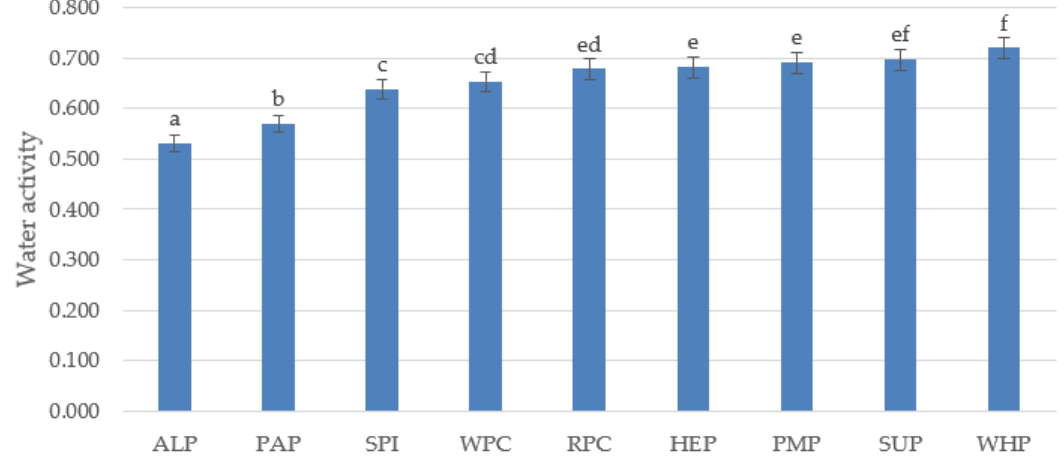
Figure 1. ( a – i ) Microstructure of high-protein bars from the scanning electron microscope (SEM HV: 30 kV, View field: 271 μm, SEM MAG: 800×).